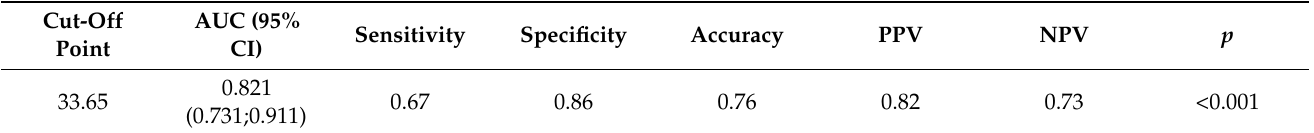
Table 5. ROC analysis results—assessment of predictive value of FOXP3 for asthma